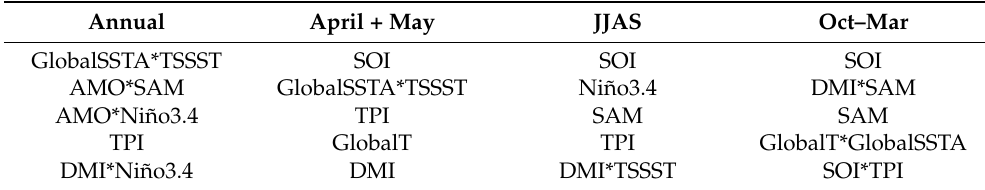
Table 2. Major precipitation attributes identified for each time period. The five major precipitation attributes identified, for each time period. They had the highest percentages of appearances in the 10-fold, cross-validation of the machine learning schemes, applied to the 1965–2018 observed precipitation data